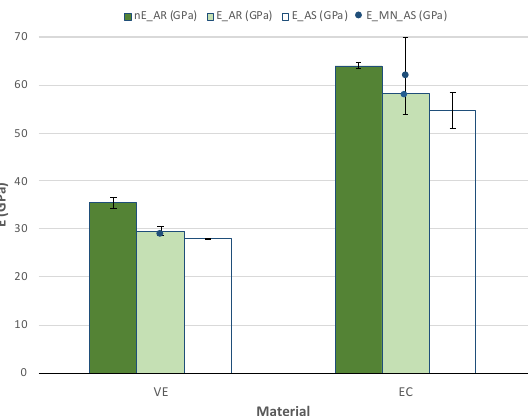
Figure 7. Elastic modulus (mean and standard error) was obtained from nano-indentation tests (nE), TPB tests (E) in the AR and AS states and data from the manufacturer (MN).